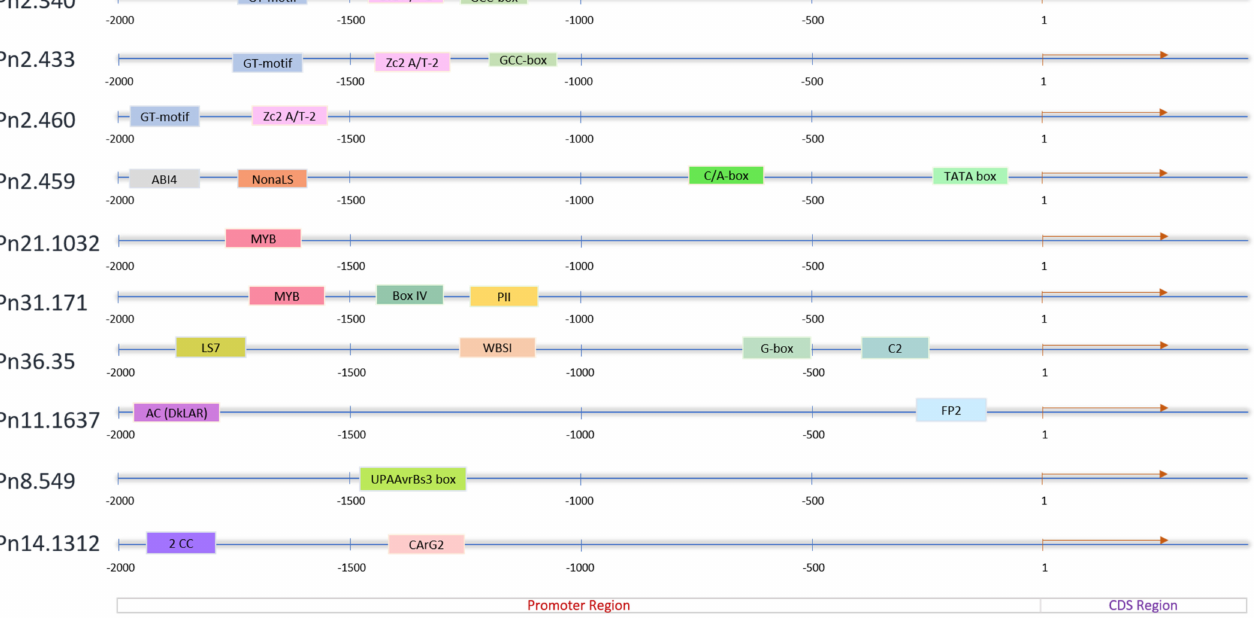
Figure 4. Analysis of the cis-acting elements of the PnRR-1 promoter regions (2 kb upstream from the CDS region) using Softberry software. Each element is represented with different